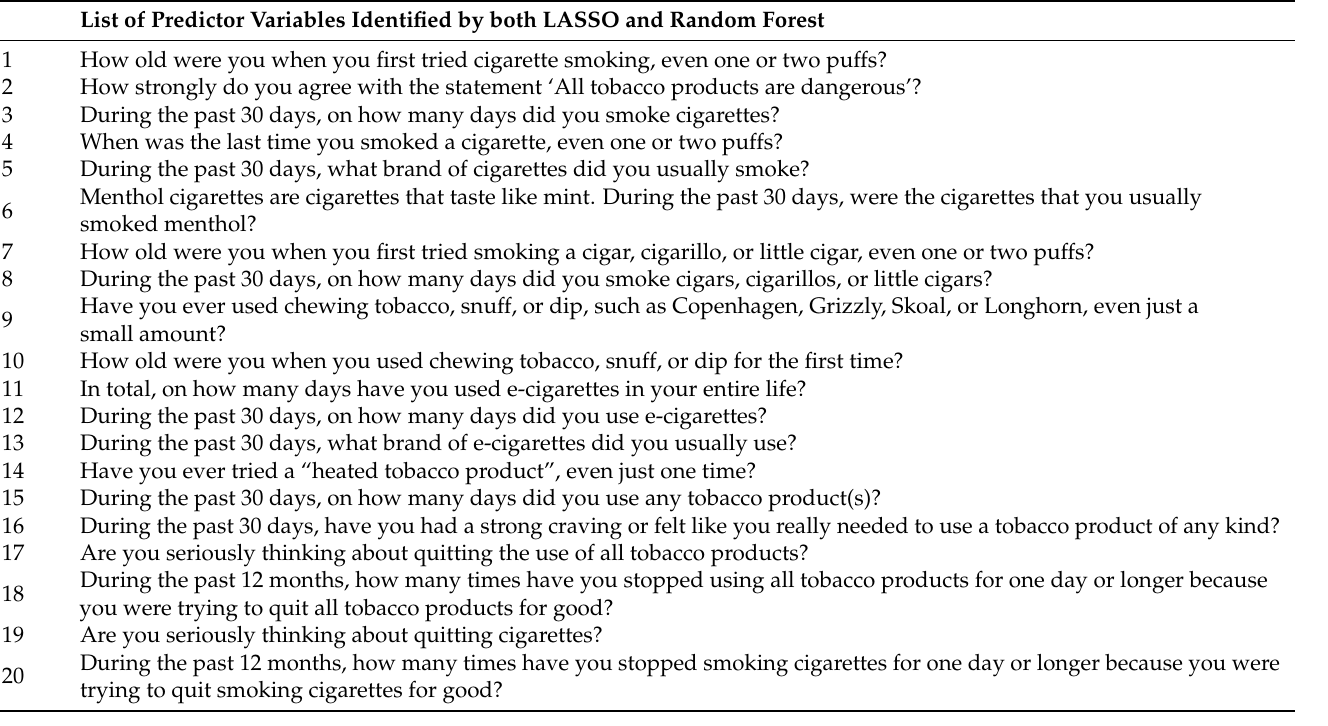
Table 4. Predictor variables used both by LASSO and Random Forest.